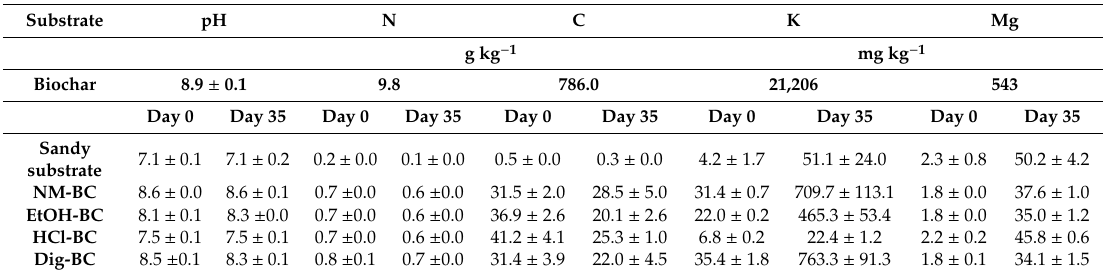
Table 2. pH and nutrient content of the used biochar, the pure sand (control), and its mixtures with biochars (BC). Biochar was treated prior to substrate application by washing with ethanol (EtOH-BC) and hydrochloric acid (HCl-BC) to remove ashes and labile organic compounds. Another portion of the used biochar was loaded with nutrients by using digestate (Dig-BC). Substrate properties (i.e., pH; total C and N; plant-available K and Mg) are shown for the beginning of the experiment (day 0) and the last day of this experiment (day 35). The table shows means and standard deviations ( n =